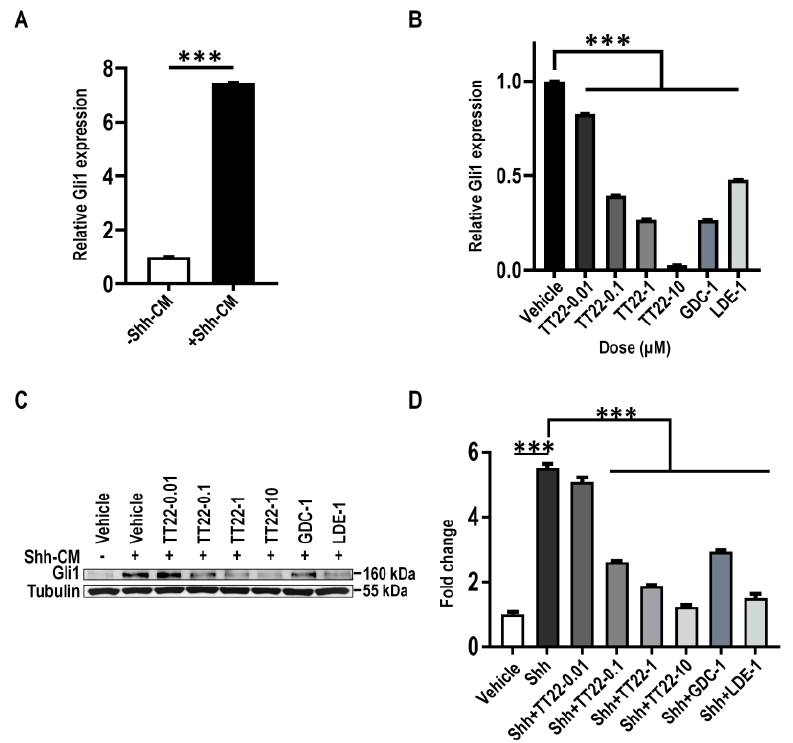
Figure 7. The expression of Gli1 stimulated with Shh-CM was suppressed by TT22. ( A ) Serum-starved NIH3T3 cells were treated with Shh-CM for 24 h, then analyzed for mRNA levels of Gli1. ( B , C ) Serum-starved NIH3T3 cells were induced by Shh-CM with DMSO (vehicle), with an indicated concentration of TT22, 1 µ M LDE-225 (LDE-1) or 1 µ M GDC-0449 (GDC-1) for 24 h. Cells were analyzed for mRNA levels ( B ) and the protein levels ( C ) of Gli1. ( D ) Quantitation of Gli1 protein levels normalized to Tubulin loading control measured the dose-dependent inhibition of the Hh pathway activity by TT22 upon Shh stimulation. All data are means ± SEM (Student’s t -test and one-way ANOVA). *** p < 0.001.